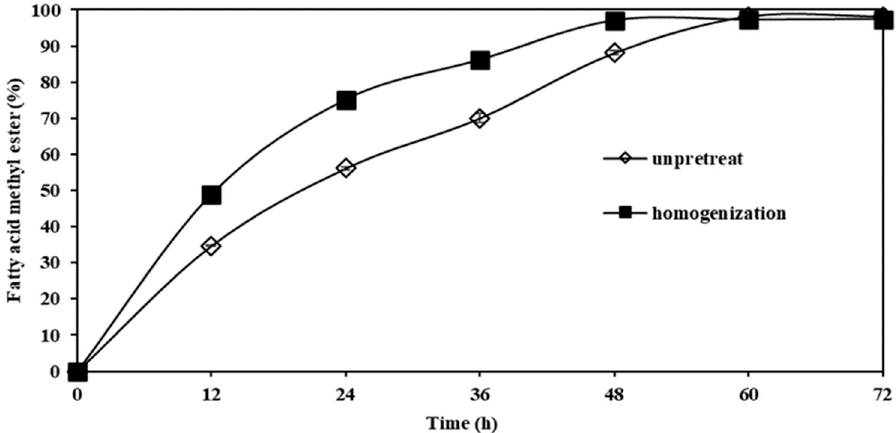
Figure 9. The scale-up of biodiesel production in a 20 mL vial and the e ff ect of palm oil pretreatment by homogenization before using as a substrate in biodiesel production using M. spicifer SPB2 cells from a 5-L stirred-tank bioreactor 5 × 10 9 of yeast cells per gram substrate in the presence of palm oil and methanol with a molar ratio of 1:7, incubated at 30 ± 2 °C for 72